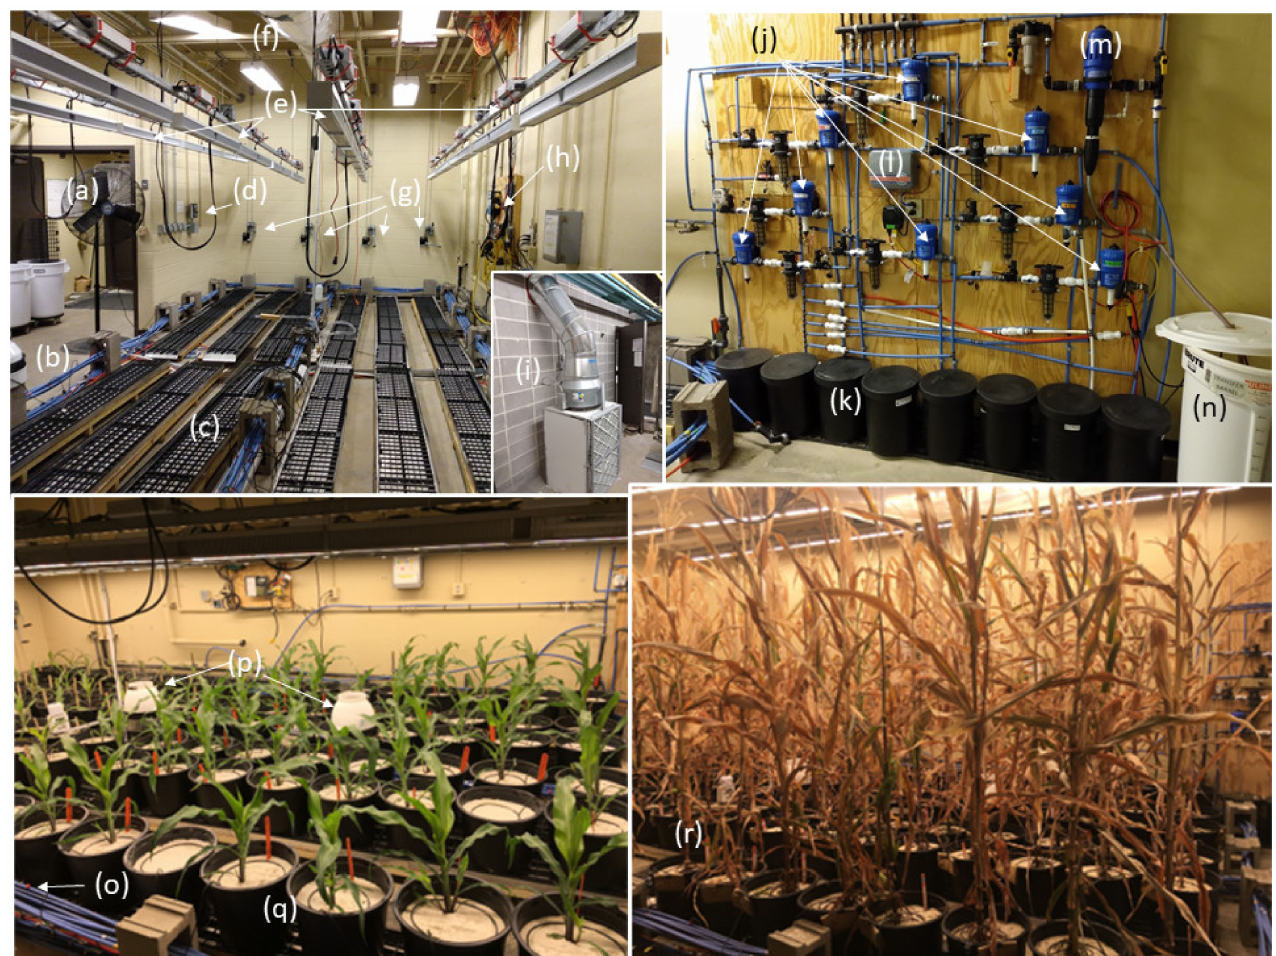
Figure 1. Several components of the grow room. ( a ) Oscillating fan; ( b ) irrigation pipe containing drip emitters; ( c ) six rows of sloped trays for holding pots and draining water; ( d ) astronomical timer; ( e ) four rows of LED lights and power sources mounted on struts; ( f ) air duct for incoming air plus temperature, humidity, and CO 2 sensors hanging from ceiling; ( g ) pulleys for raising/lowering LED lights; ( h ) controls for activating air handler and humidifiers; ( i ) air handler with filter located in “lung room” connected to air duct; ( j ) eight small nutrient injectors for applying treatments; ( k ) containers for treatment concentrate solution; ( l ) timer/controller for irrigation; ( m ) large nutrient injector for all non-treatment nutrients; ( n ) container for non-treatment nutrient concentrate; ( o ) drip emitter, one per pot; ( p ) humidifiers; ( q ) pots containing silica sand and drip rings; ( r ) mature and dry maize ready for harvest. Not shown: “Watch Dog” daily logger station for radiation, relative humidity and temperature, air conditioners, and louvers for exit